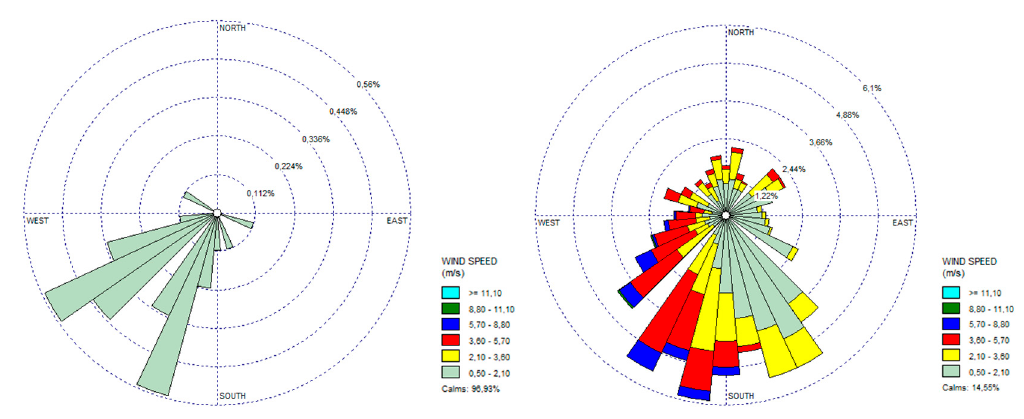
Figure 4. Rose winds (direction and average wind speed) for SC3 and SC6 periods.